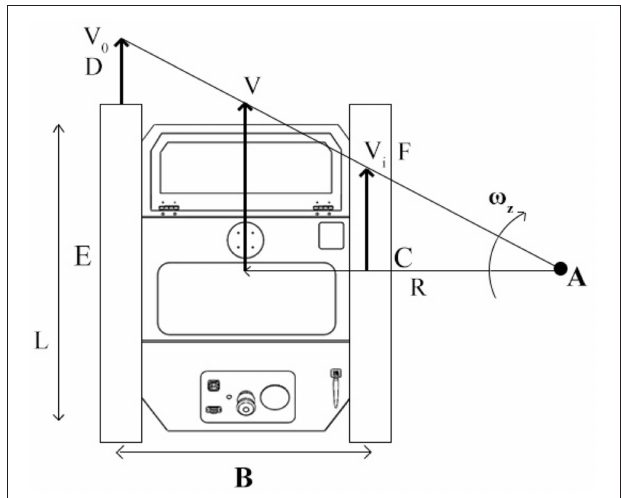
FIGURE 8 | The kinematic for a skid-steering tracked vehicle during a clockwise steering maneuver where B is the width of the vehicle body, V 0 is the velocity for the outer track and Vi is the velocity for the inner